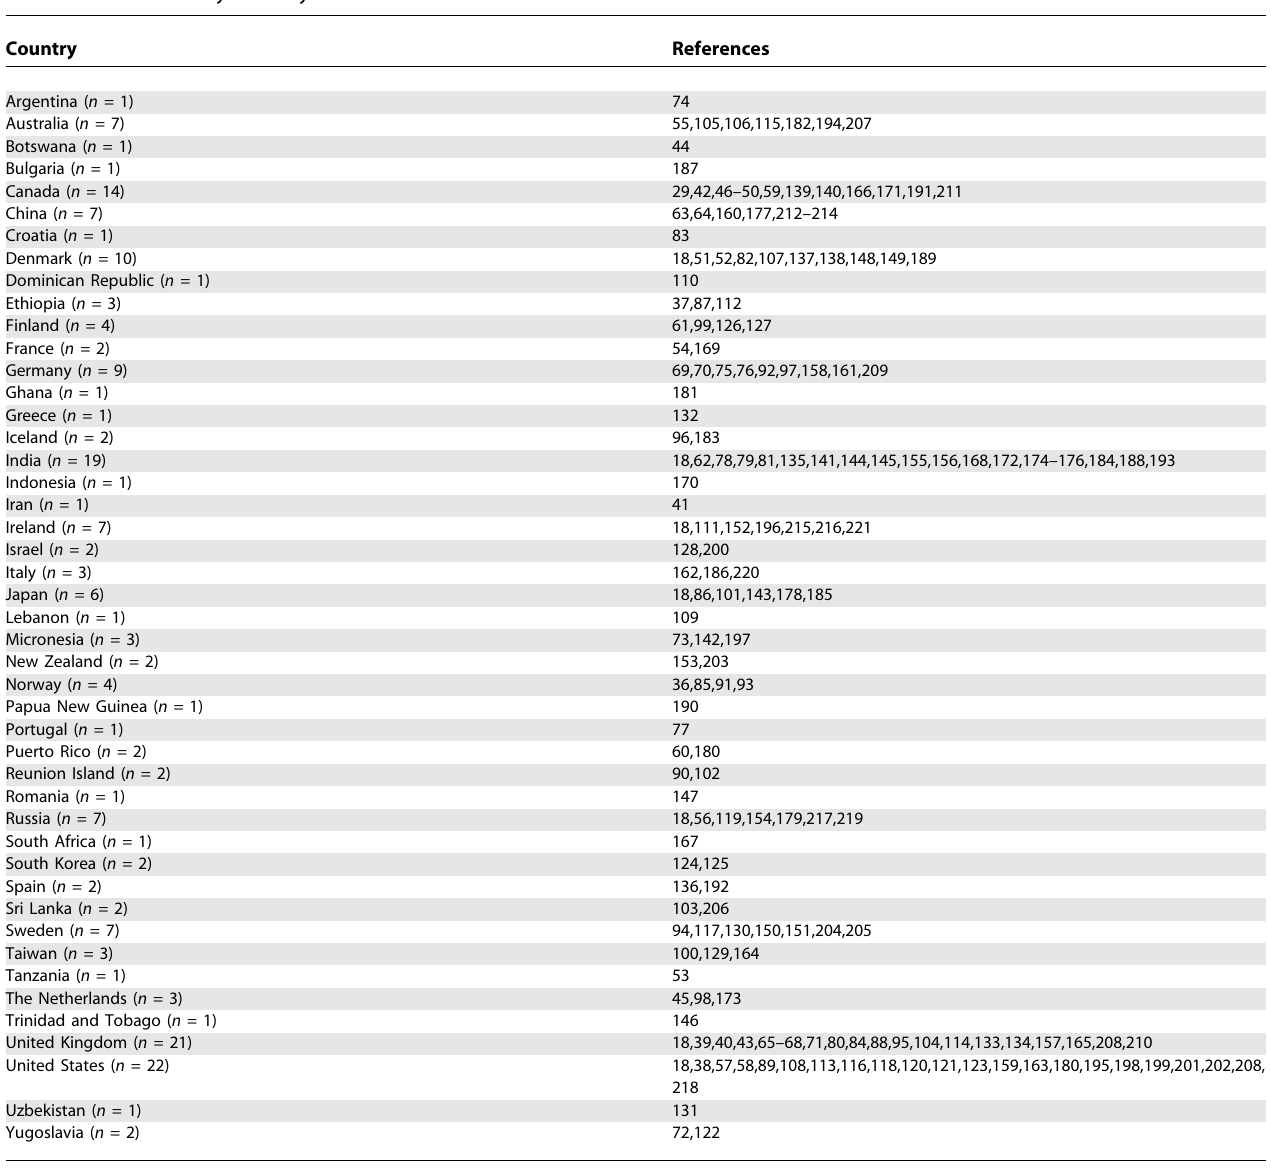
Table 3. References by Country Country